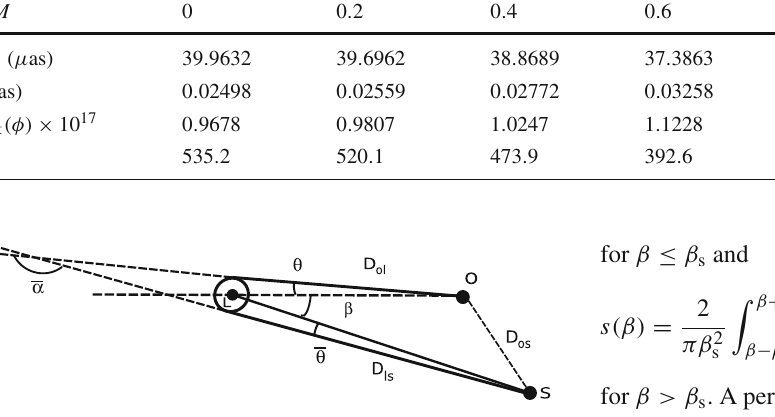
Fig. 4 Configuration of retro lensing. A ray emitted by a source S is reflected with an effective deflection angle ¯ α by the photon sphere of a lens object L and it reaches to an observer O. We introduce an source angle β ≡ (cid:11) OLS and an angle ¯ θ defined by an angle between a line LS and the ray at S